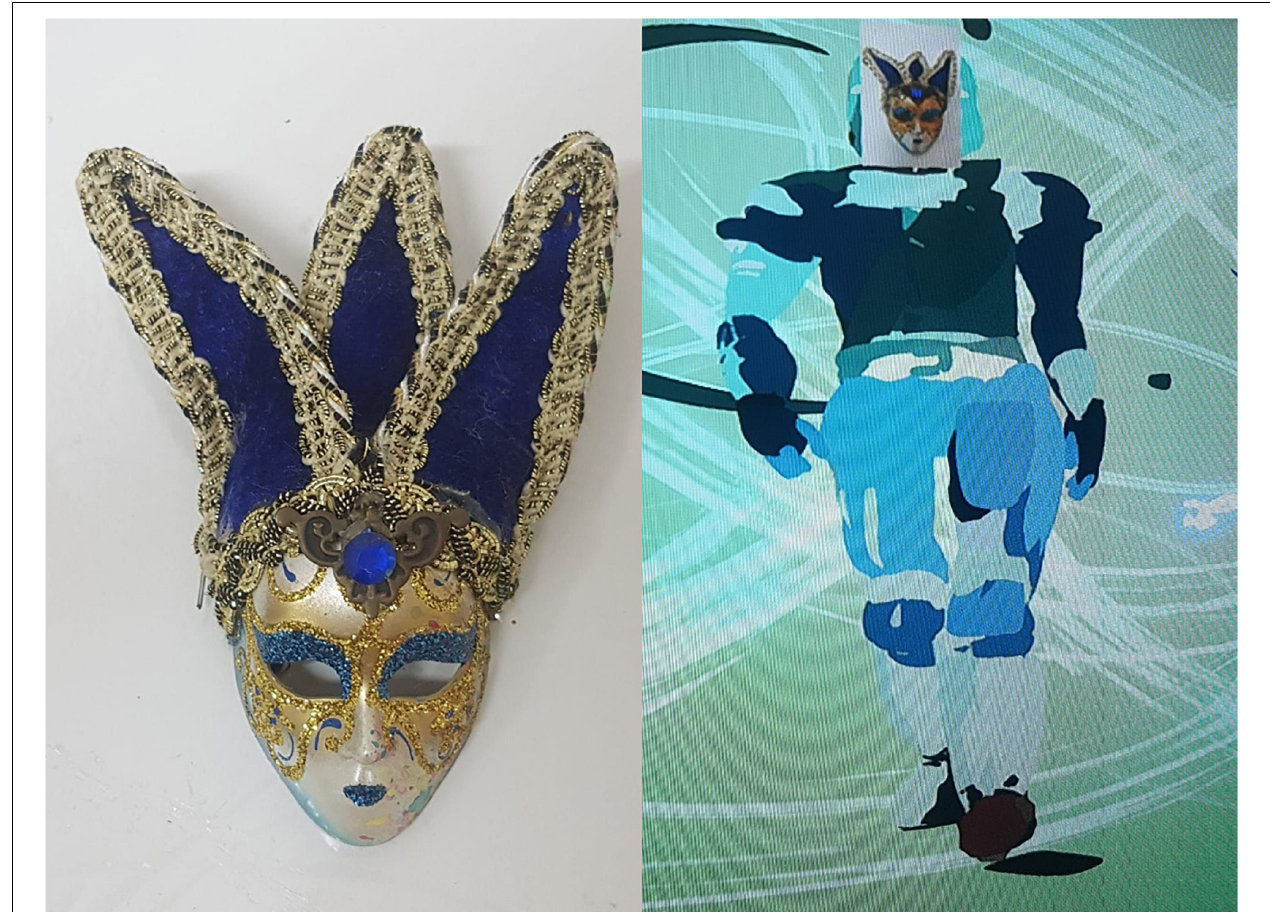
FIGURE 4 | Eric’s